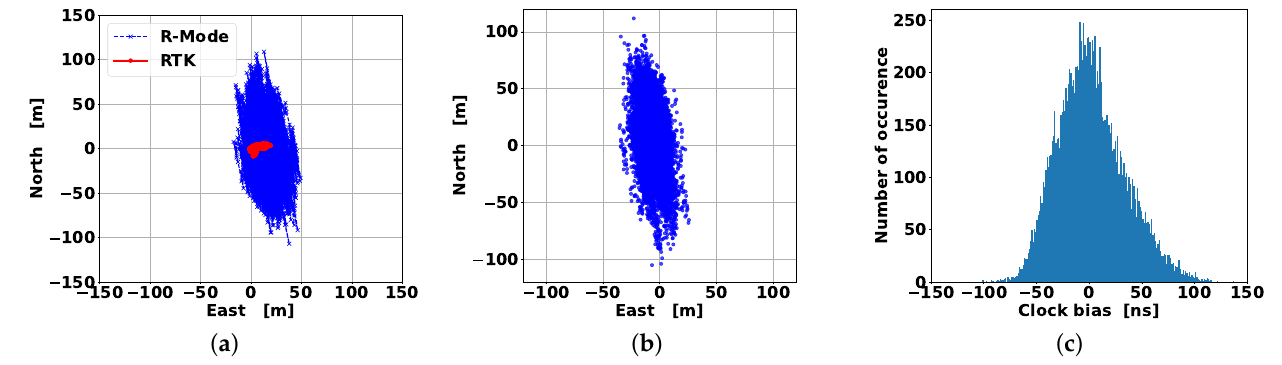
Figure 8. Night-time results. ( a ) Reference RTK (red circles) and R-Mode (blue crosses) tracks. ( b ) Scatterplot of the R-Mode positioning error in the east and north. ( c ) Histogram of the estimated receiver clock